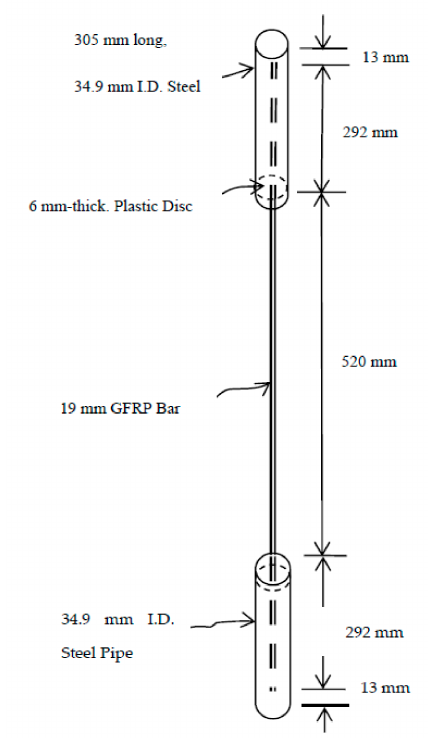
Figure 1. Tensile Test Specimen.